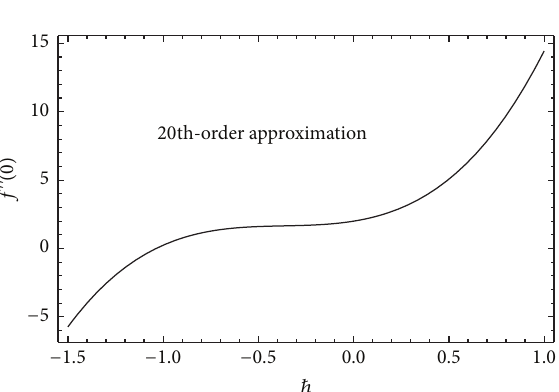
Figure 2: ℎ -curve for 𝑀 = 1, 𝐾 𝑤 = 0 , and 𝛾 = 2 .